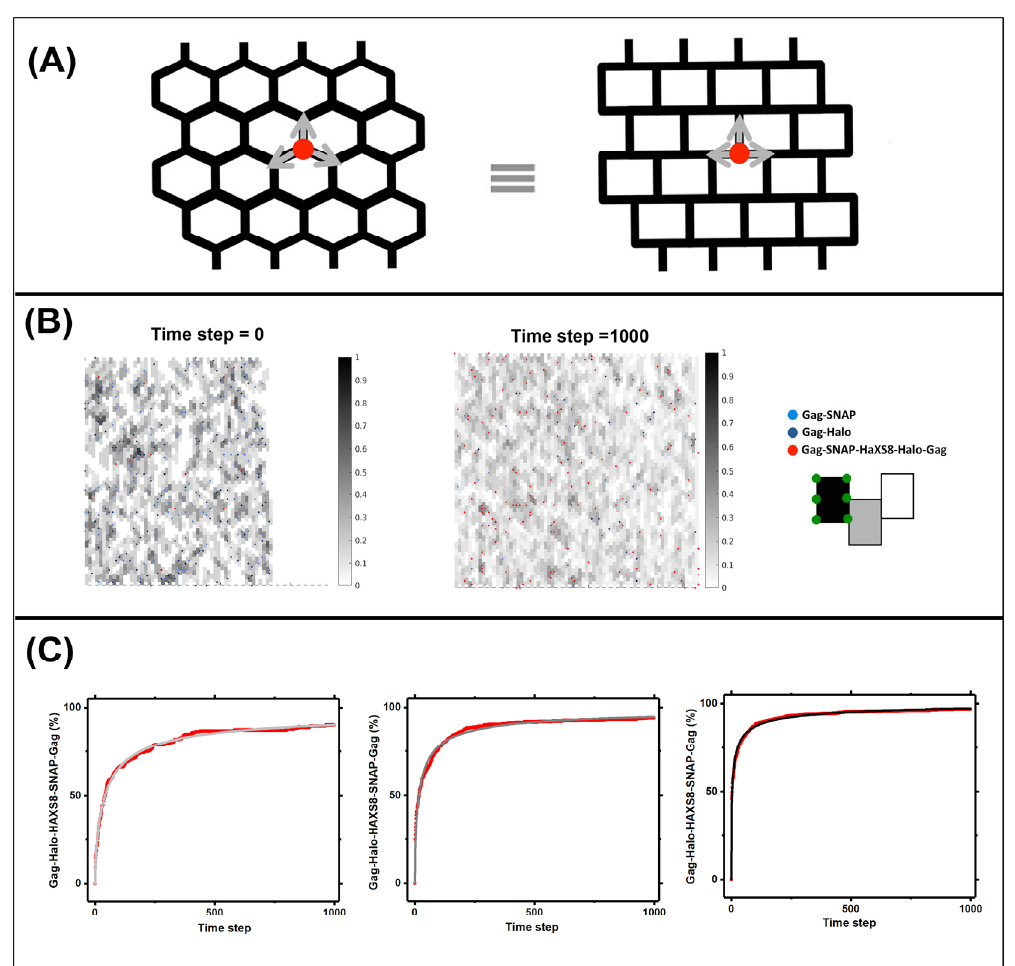
Figure 3. Monte Carlo model of Gag dynamics. In this model we assume that the full surface of the VLP is covered by a lattice as shown in ( A ) Gag molecules are initialized onto this lattice at time point zero and occupy 80% of the lattice. At each subsequent time interval, each Gag molecule is moved according to its position on the lattice and occupancy state of the neighboring vertexes. There was no barrier for leaving a vertex and any vertex could be entered upon as long as it had a lower occupancy than three Gag molecules. ( B ) When a Gag-SNAP and a Gag-Halo molecule occupy the same vertex, they will bind to each other and form a heterodimer. The hetero dimers remain bound to the end of the simulation. ( C ) Percentage of hetero-dimer formation in the simulations with 10%, 20% and 40% Gag-SNAP and Gag-Halo proteins were fitted to the mathematical model presented in the text and shown in